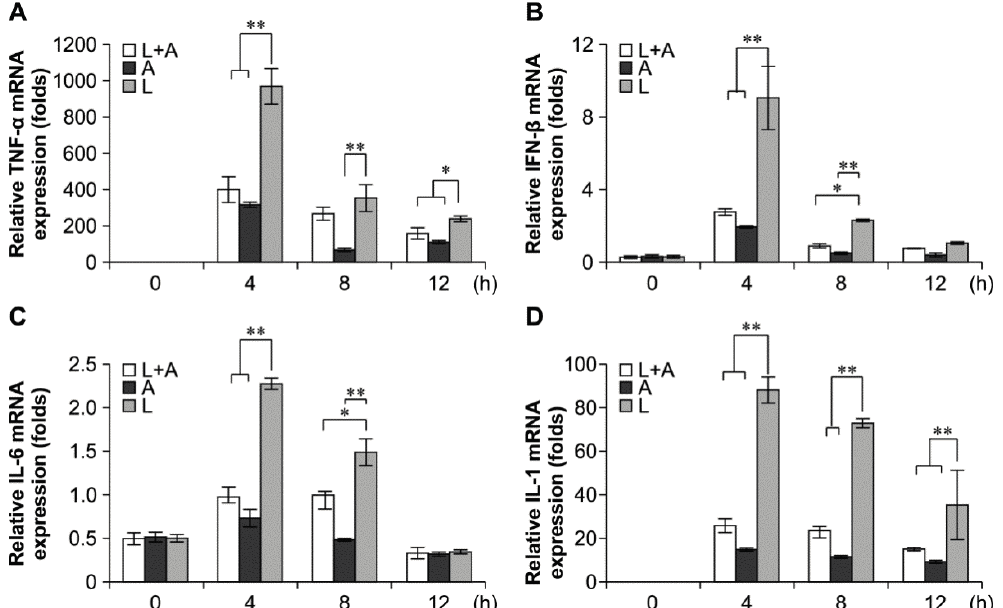
Figure 4. Inhibitory effect of Fab on cytokine transcription in LPS-stimulated mouse macrophages. Humanized anti-TLR4 antibody Fab inhibits the cytokine transcription, including TNF- α ( A ); IFN- β ( B ); IL-6 ( C ); IL-1 ( D ), in mouse macrophages stimulated by LPS. Mouse macrophages were treated with humanized anti-TLR4 antibody for 2 h, and then stimulated with 1 µg/mL LPS for 4, 8, or 12 h. After stimulation the cells were collected, and TNF- α , IFN- β , IL-1, IL-6 were measured by Q-PCR. L: LPS; A: humanized anti-TLR4 antibody. Data are shown as mean ± SD ( n = 6, * p < 0.05, ** p < 0.01 compared to LPS